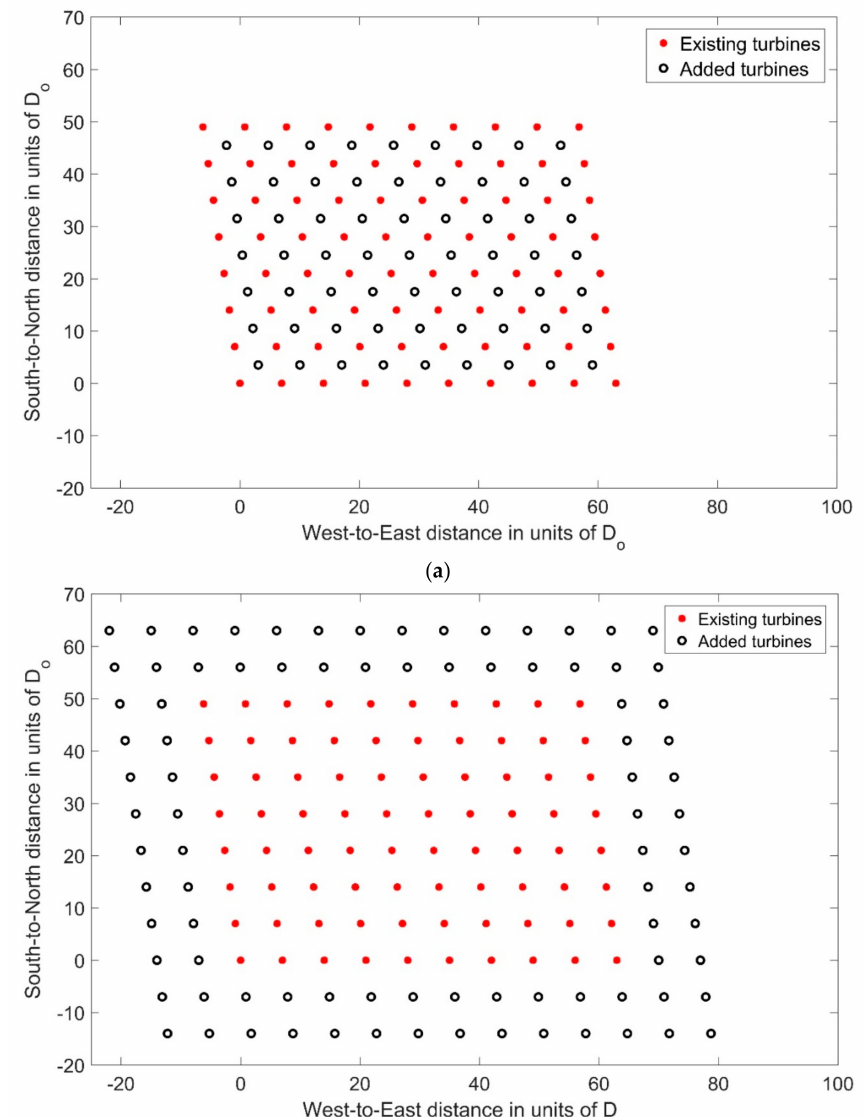
Figure 3. Two proposed upgrade layouts for Horns Rev 1 wind farm. ( a ) Internal grid; ( b ) External grid. The vertical coordinate indicates the